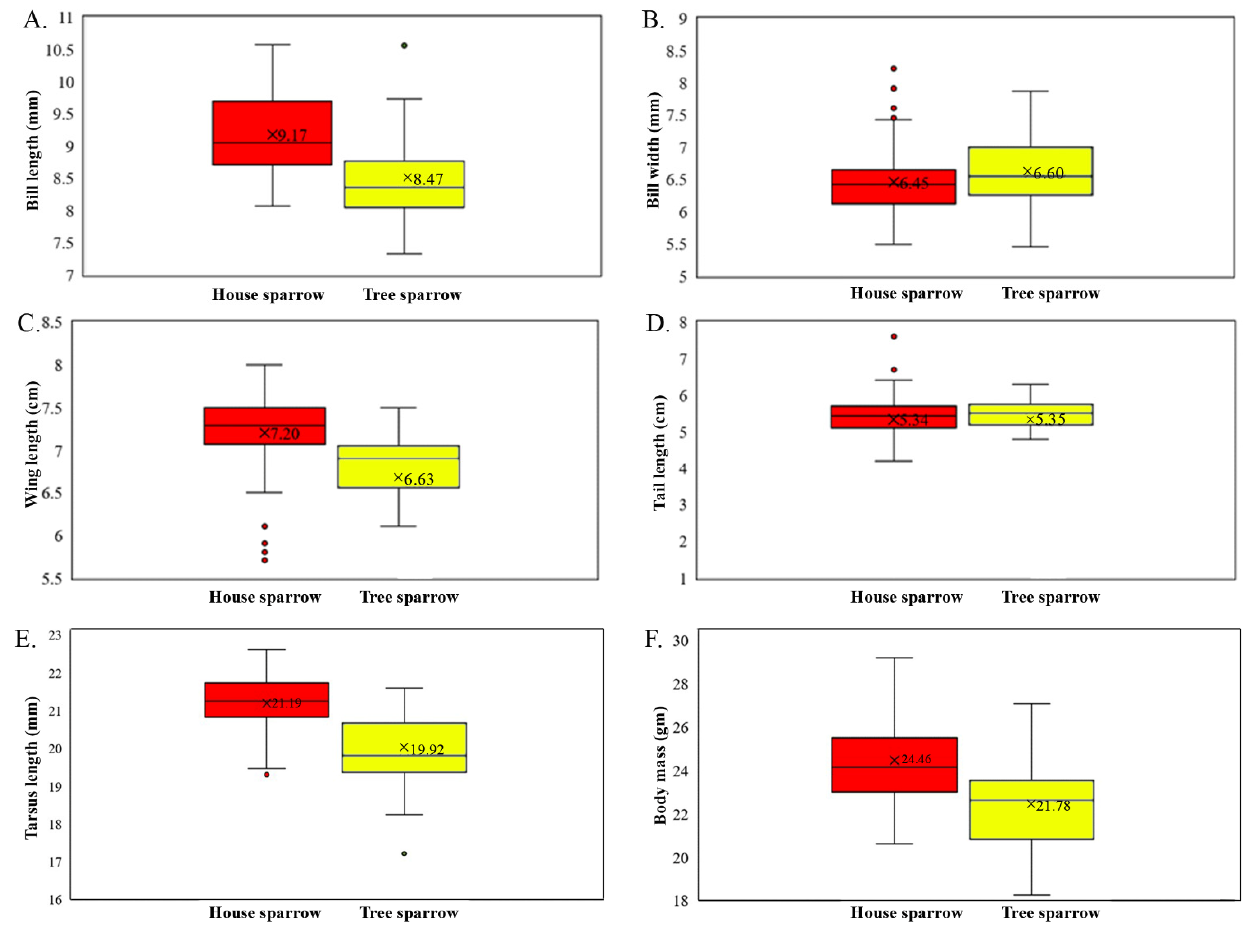
Figure 3. A comparative account of morphological measurements in Passer domesticus and P. montanus: ( A ). Bill length; ( B ). Bill width; ( C ). Wing length; ( D ). Tail length; ( E ). Tarsus length; and ( F ). Body mass. The lines and values inside the boxes indicate the medians and means, respectively.